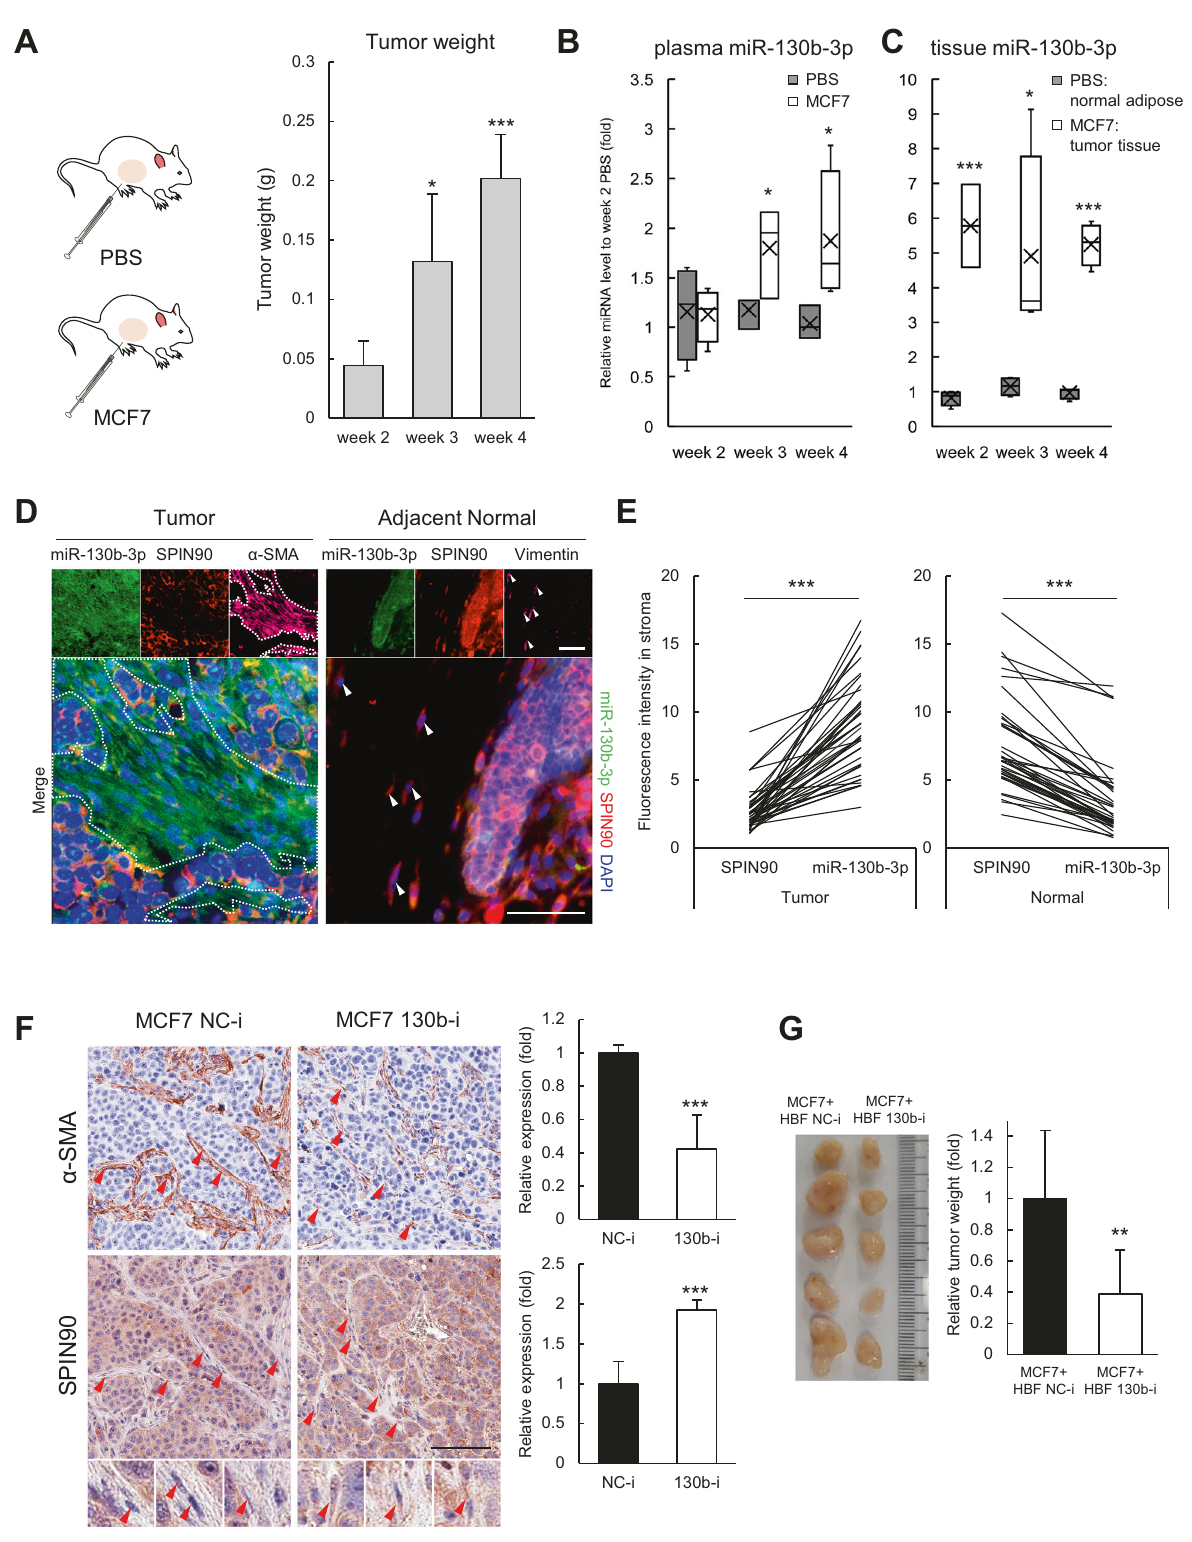
SPIN90 was originally identi fi ed as an adaptor protein that regulates actin polymerization and lamellipodium formation [40]. We recently reported on how SPIN90 modulates fi broblast activation and breast cancer. Depletion of SPIN90 in fi broblasts promotes microtubule stabilization and leads to the